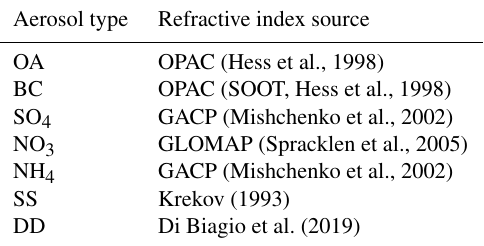
Table A2. References of the refractive indices associated with the aerosol types in ARPEGE-Climat. The organic aerosol type is a combination of three OPAC types similar to a continental mixture, as described in Hess et al.